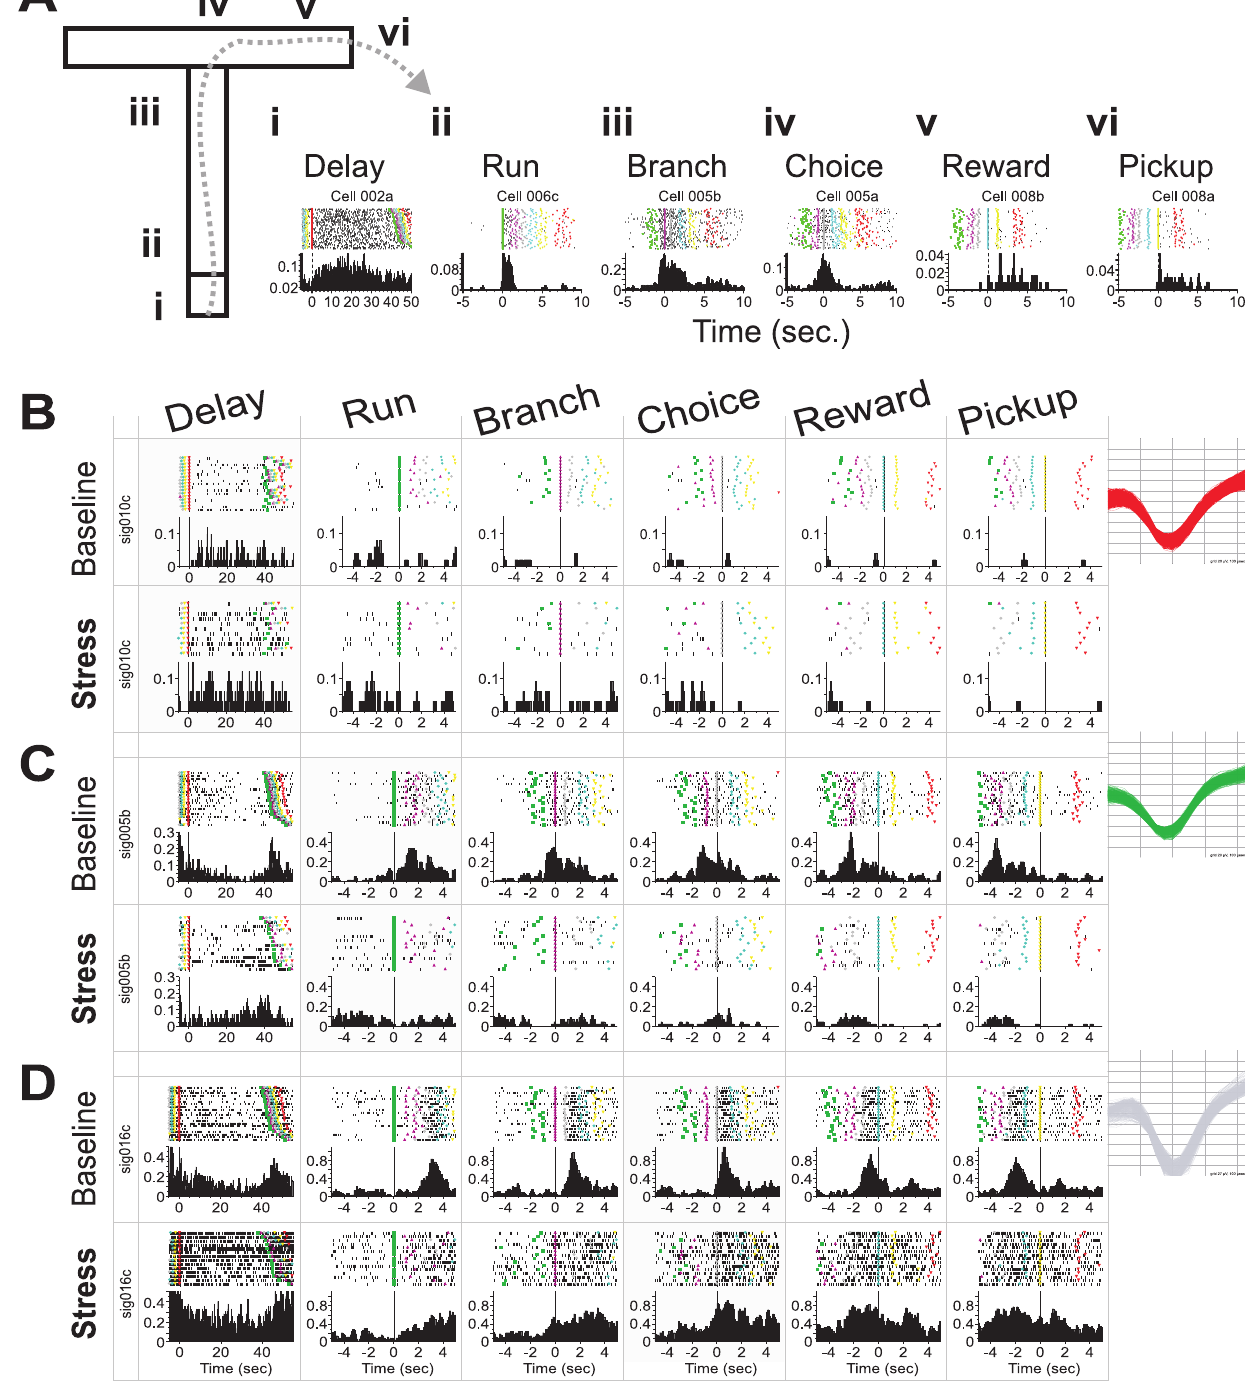
Figure 2. Peri-stimulus time histograms (PSTHs) illustrate the effects of stress on pl PFC neuron task-related spiking activity. A ) T- maze schematic and associated peri-event raster and histogram analysis illustrates prototypic (i) delay- (ii) run- (iii) branch- (iv) choice- (v) reward- and (vi) pickup-related activity observed from pl PFC neurons (0 sec.=start of respective behavioral interval; n=40 correct trials of a baseline recording session; Delay length=20 sec.; 5 msec. bins). Colored fiduciaries indicate beginning of each major event of the T-maze task (Red, Start Box; Green, Gate; Magenta, Branch; Grey, Choice; Cyan, Reward; Yellow, Pickup). B ) Task-related discharge of a single WS-type pl PFC neuron during correctly executed trials with a left arm entry during the baseline recording session (17 trials; top) and subsequent stress session (11 trials; bottom). Delay- related spiking of this delay neuron was enhanced during stress. Inset illustrates recorded spike waveforms. PSTH y-axis represents spiking probability/bin normalizing for different numbers of trials (5 msec. bins). C ) Run-related activity suppressed during stress conditions. D ) Suppression of choice-related activity during stress. Labeling conventions of C–D are identical to B.